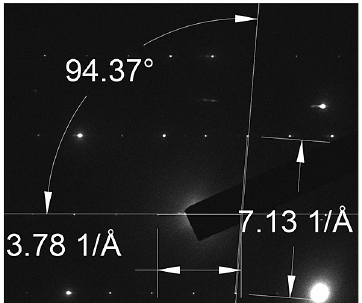
Figure 9. Measured angle and spacings for nanowire grown without Ag.